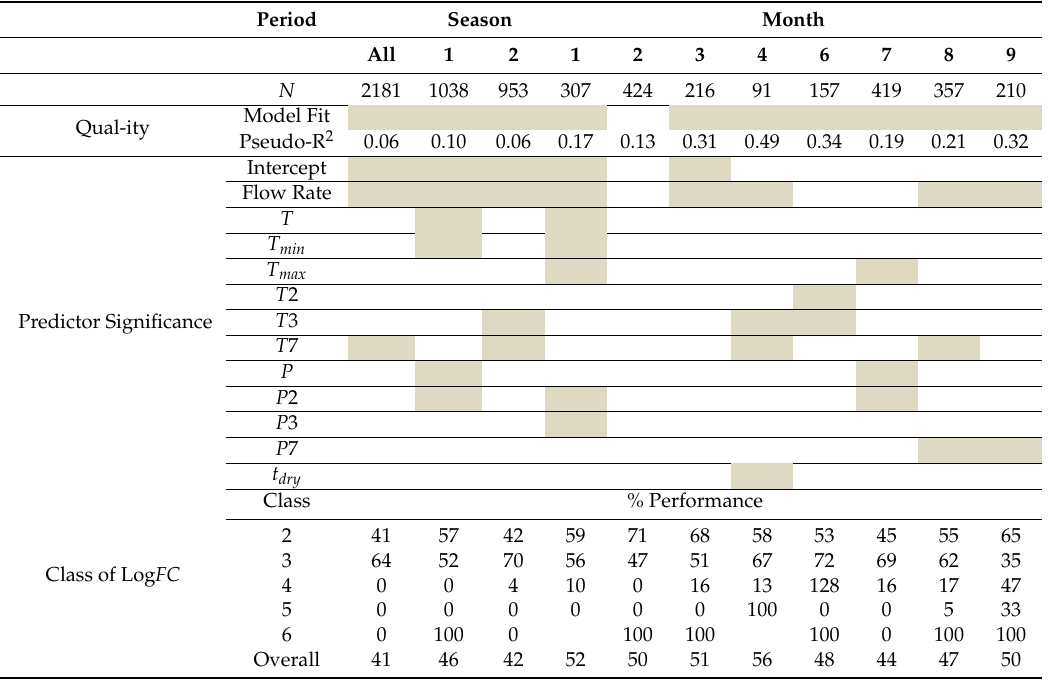
Table 4. MLR modelling results for Log FC i,j for all stations. A shaded box indicates a significant relationship with no shading indicating the p -value was greater than